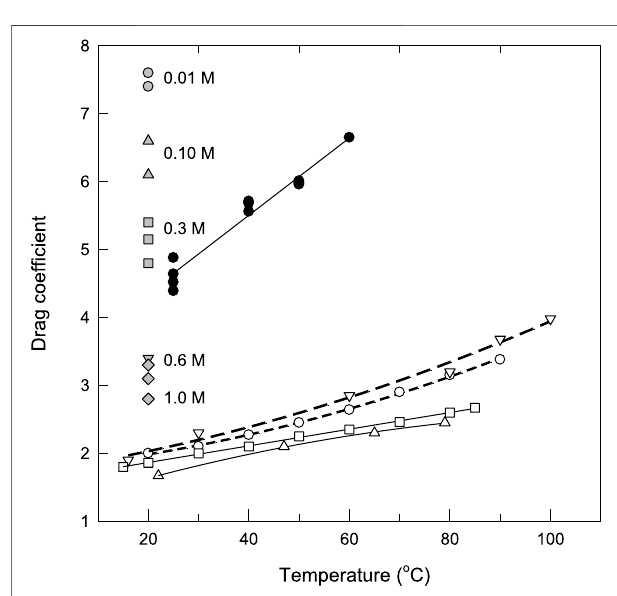
FIGURE 3 | Electro-osmotic drag coef fi cient of water in Na fi on membranes as a function of temperature: (=) this work, ( ° C) λ = 22 (Ren et al, 1997),( □ ) λ =22.5(Luoetal,2010),( Δ ) λ =13(Iseet al,1999),and( ◊ ) λ =16.8 (Ge et al, 2006). The gray symbols correspond to the data by Pivovar etal.(Pivovaretal.,2005)forNa fi on117inthepresenceofaqueousHClatthe indicated